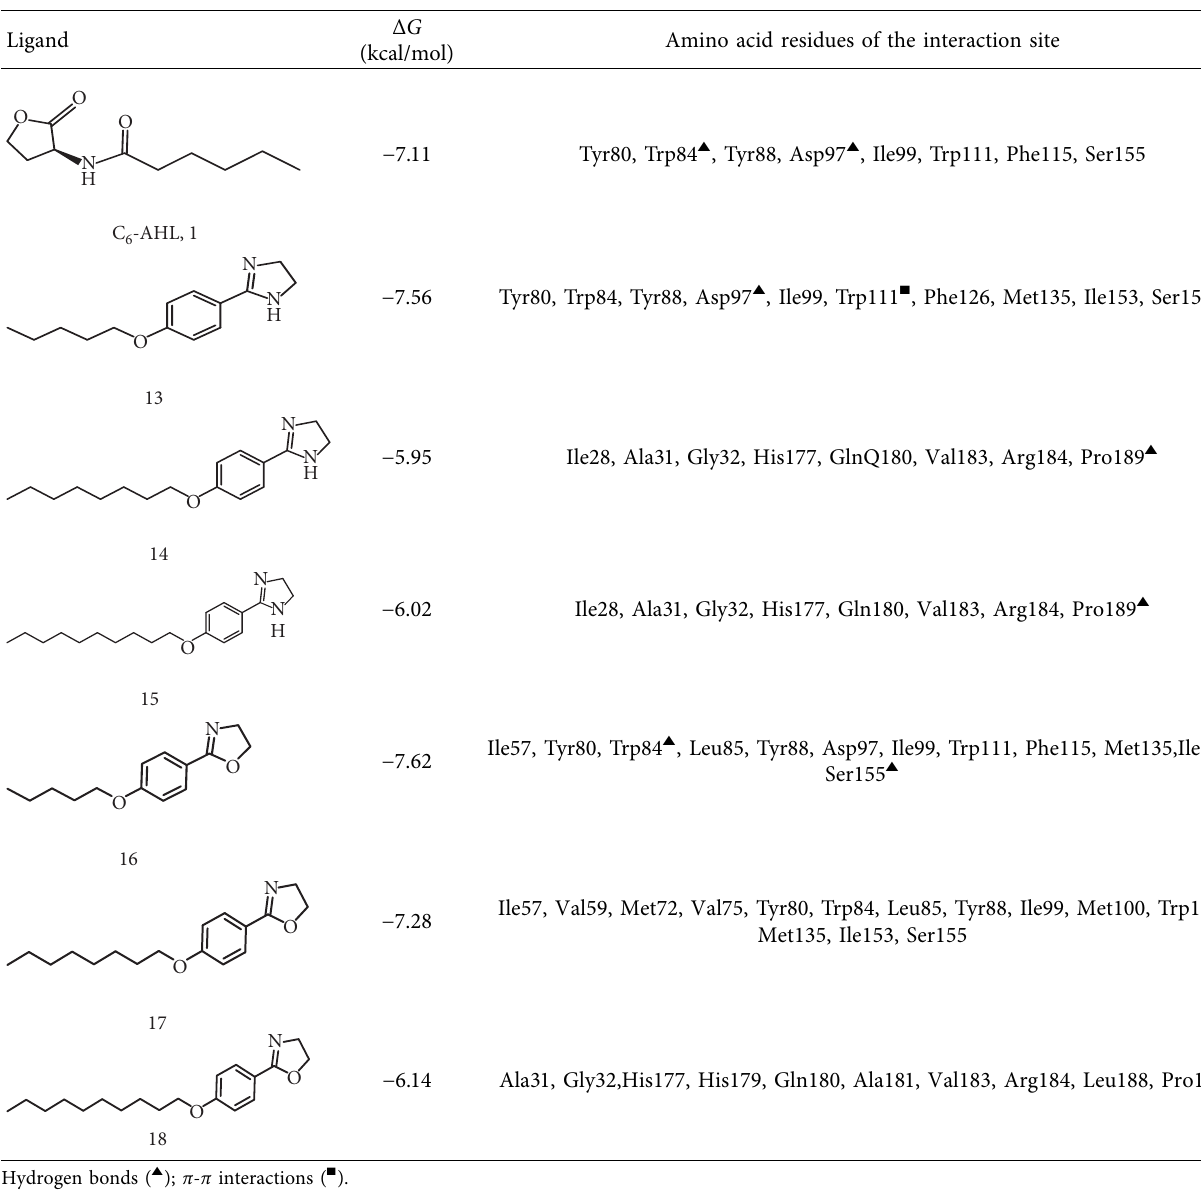
Table 2: The Δ G values for the ligand-protein interactions and the amino acid residues of the protein involved in binding. Δ G Ligand Amino acid residues of the interaction (kcal/mol)